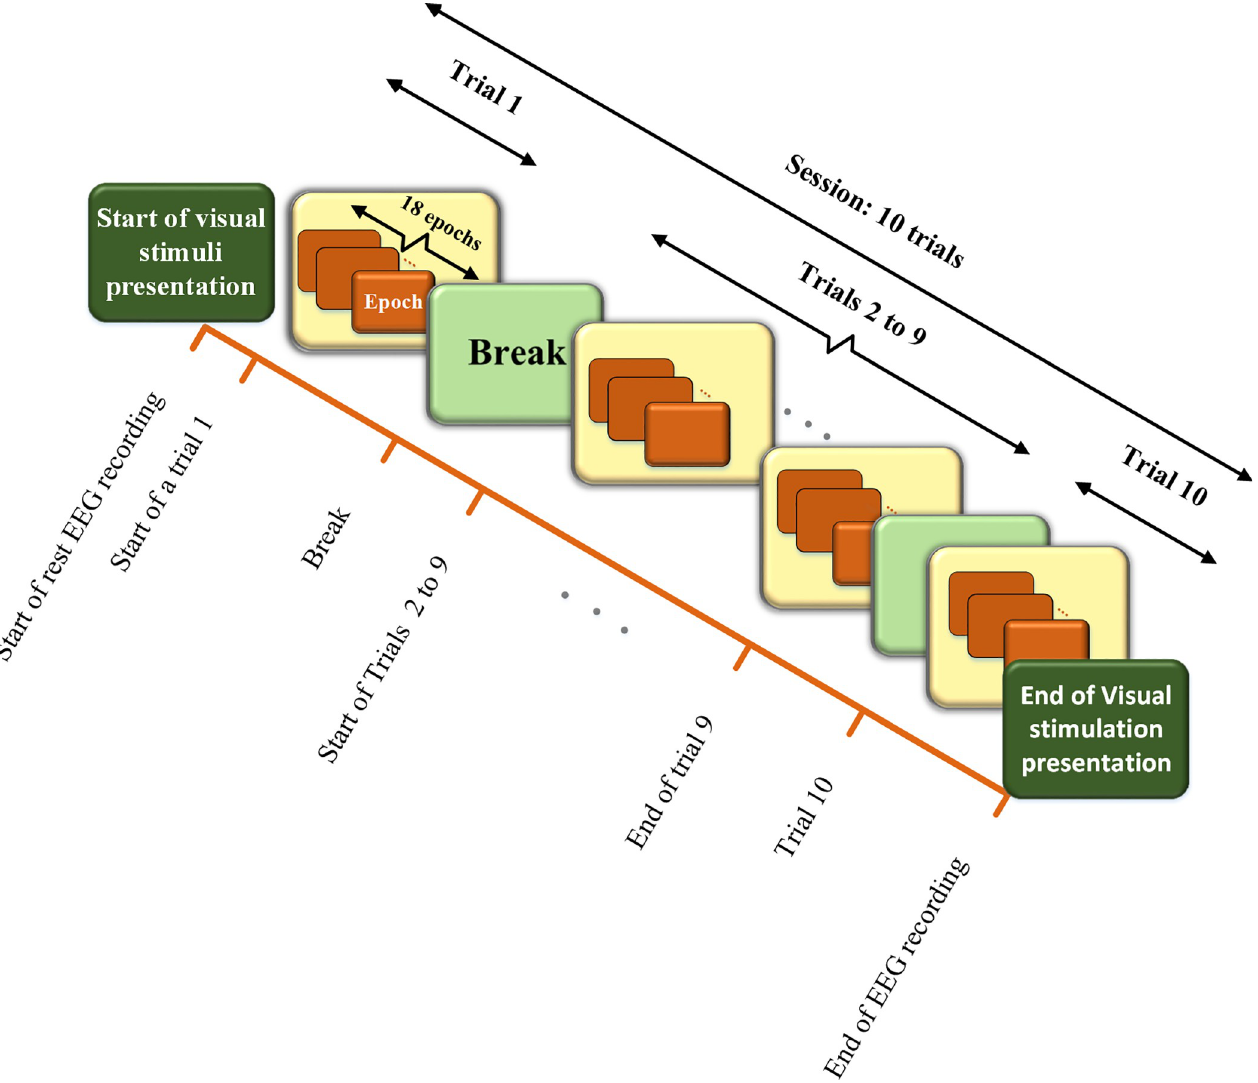
Fig 6. The stimuli presentation diagram for single session: A single session consisted of 10 trials presenting m-sequence or chaotic code visual stimuli. Each trial had 18 consecutively presented epochs. Each epoch presented a single visual stimulus code. Each trial was followed by 2 second break time. As there were 4 m-sequence ( M 1 − M 4 ) and 4 chaotic codes ( Ch 1 − Ch 4 ), each subject had total 8 sessions of stimulus presentation (see Fig 7 and text for details).